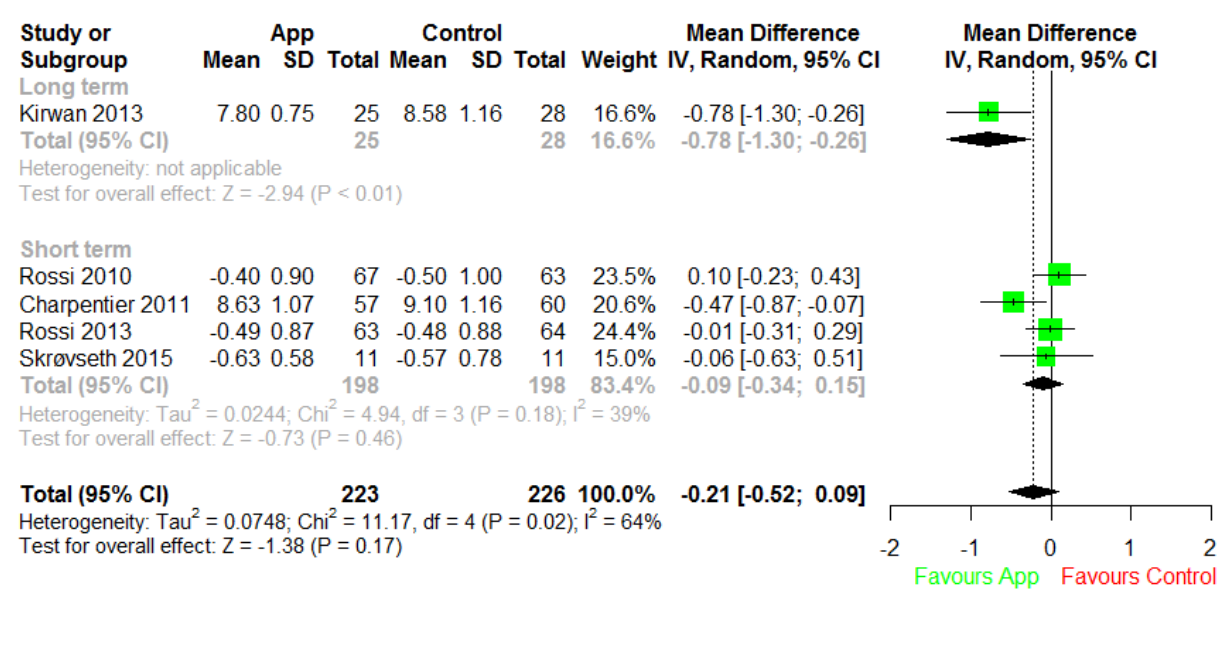
Figure 4. Forest plot of short- and long-term effects of apps for type 1 diabetes mellitus. IV: inverse